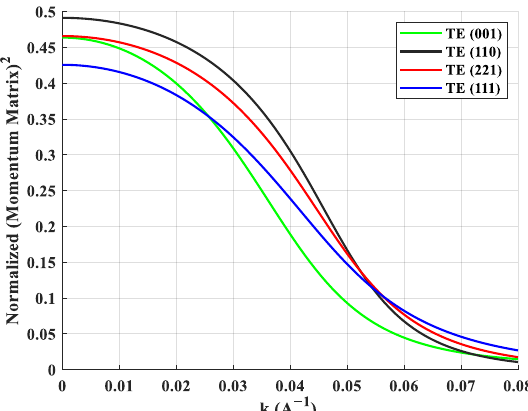
Figure 5. Crystal orientation–dependent normalized momentum matrix element square for the C1–HH1 transition.